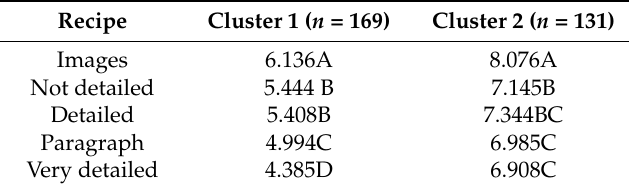
Table A3. ANOVA per cluster, wheat study.